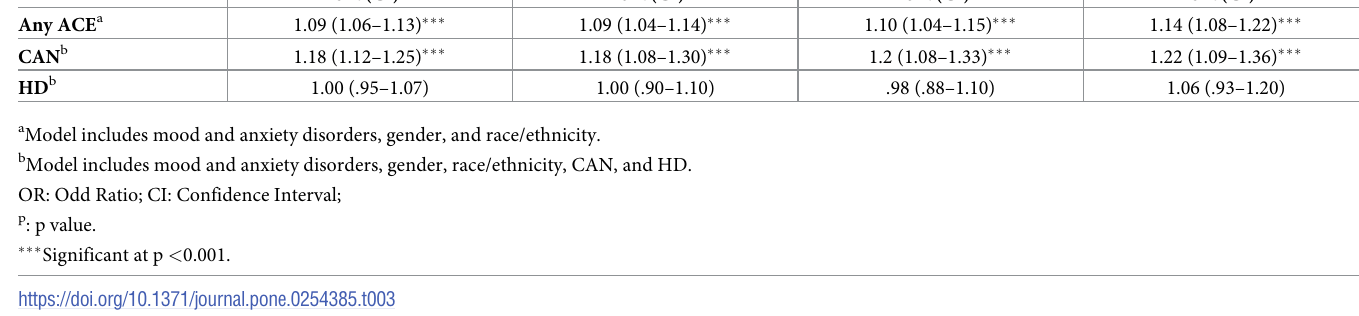
Table 3. Adjusted odds between any ACE or ACE composites, and suicidal ideation. CAN, child abuse and neglect; HD, household dysfunction.